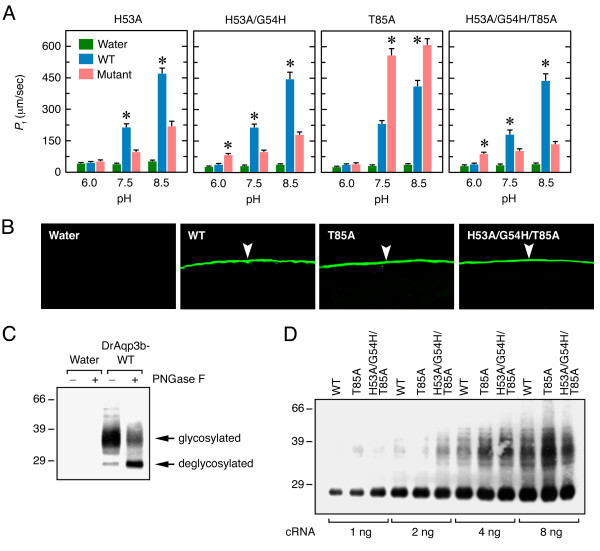
Functional characterization of DrAqp3b mutants. (A) Pf of control oocytes (water-injected) and oocytes expressing 1 ng cRNA encoding wild-type DrAqp3b (DrAqp3b-WT) or different DrAqp3b mutants at different pH. Values are the mean ± SEM of three experiments (n = 8-10 oocytes per construct). The asterisks denote significant differences between WT and mutant DrAqp3b at a given pH (Student's t test, p < 0.05). (B) Immunofluorescence microscopy of water-injected oocytes (control), or oocytes expressing DrAqp3b-WT, -H53A, -H53A/G54H, -T85A and -H53A/G54H/T85A using an affinity purified anti-DrAqp3b antiserum. The arrowhead points to the oocyte plasma membrane. (C) Immunoblot of total membrane protein extracts of control oocytes or oocytes expressing DrAqp3b-WT treated or not with N-glycosidase F (PNGase F). The arrows indicate glycosylated and deglycosylated forms of DrAqp3b-WT. (D) Representative immunoblot of plasma membrane protein extracts of oocytes expressing increasing amounts of cRNA (1-8 ng) encoding DrAqp3b-WT, -T85A and -H53A/G54H/T85A treated with PNGaseF.